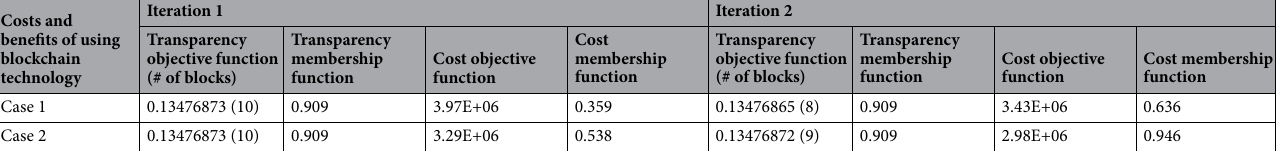
Table 3. Computational results of the improved B&E algorithm.